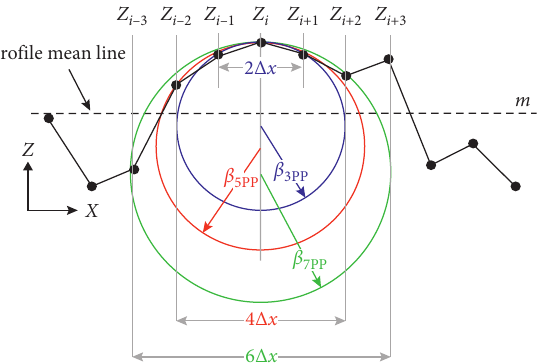
Figure 3: Schematic plot for 3PP, 5PP, and 7PP criteria on rock joint profile.